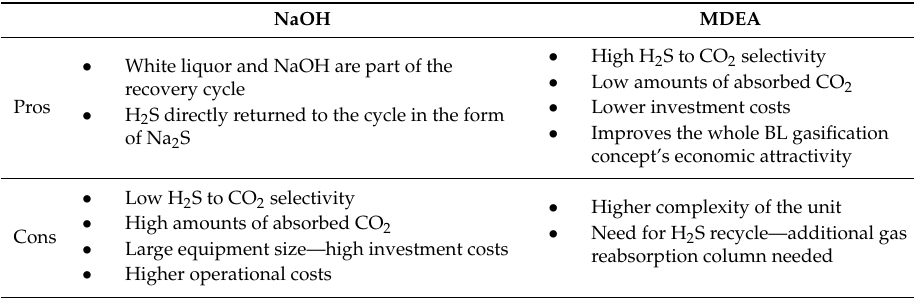
Table 17. Comparison of the absorption